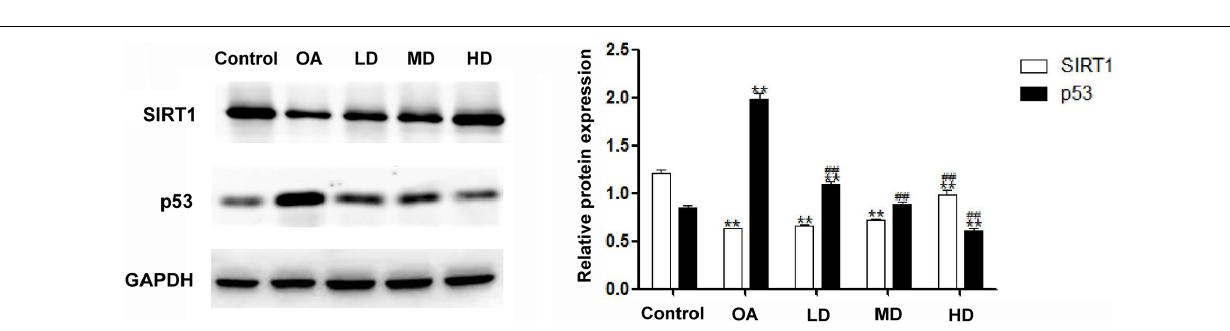
FIGURE 4 | Expressions of SIRT1 and p53 detected by Western blot. ** P < 0.05, compared with the control group; ## P < 0.05, compared with OA